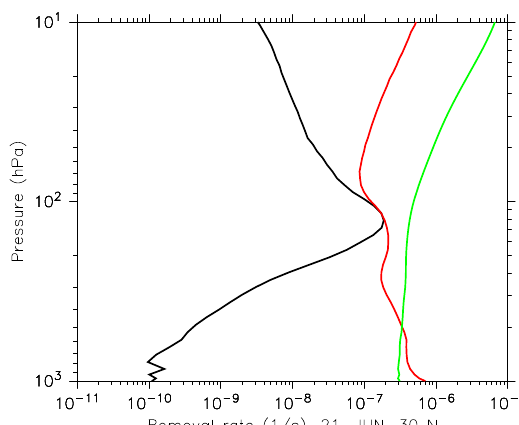
Fig. 5. CH 3 C(O)CH 3 removal rates at 30 ◦ N solstice initiated by: photolysis (R3) in green; reaction with OH (R4) in red; and in black the reaction of interest (R1) using k 1 and K 1 parameters from (Her- mans et al., 2004). See Sect. 3.3 for details.